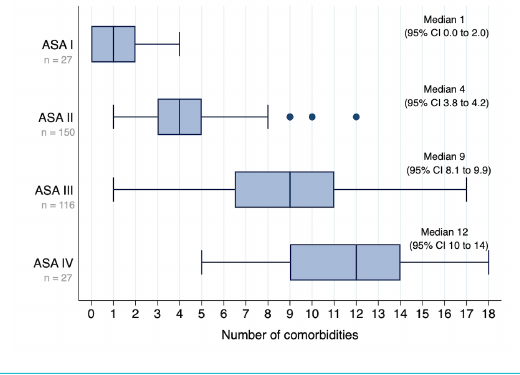
Figure 3: Median number (95% confidence interval [CI]) of comor- bidities in relation to the ASA class. Boxplots show average num- ber (IQR and range) of all anaesthesia-relevant comorbidities in each patient (regardless of severity) across all ASA classes. The confidence intervals are estimated in a median regression model using bootstrapped standard errors.